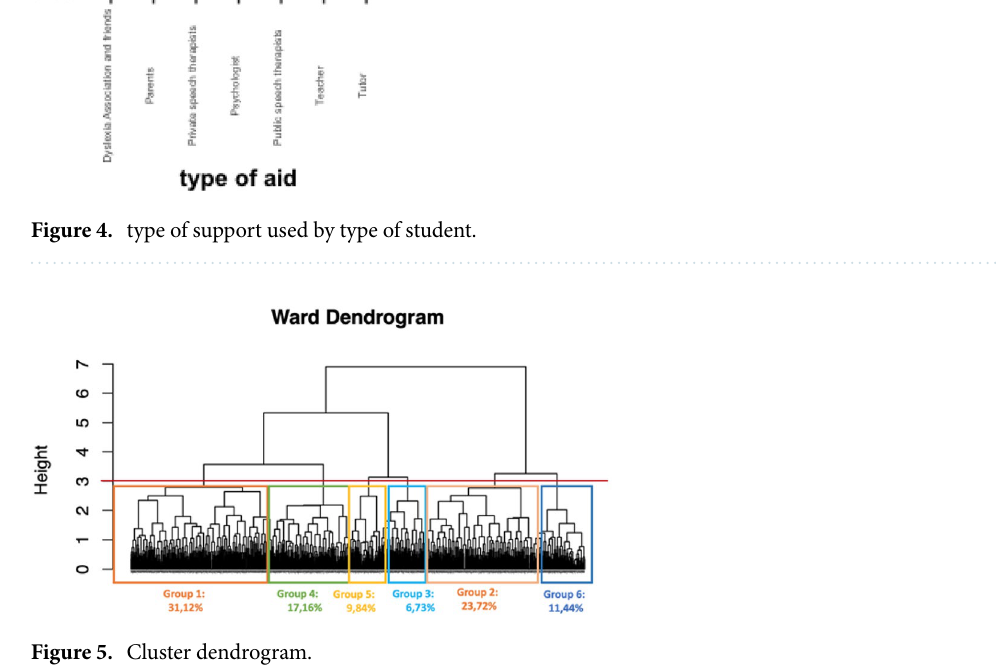
Figure 5. Cluster